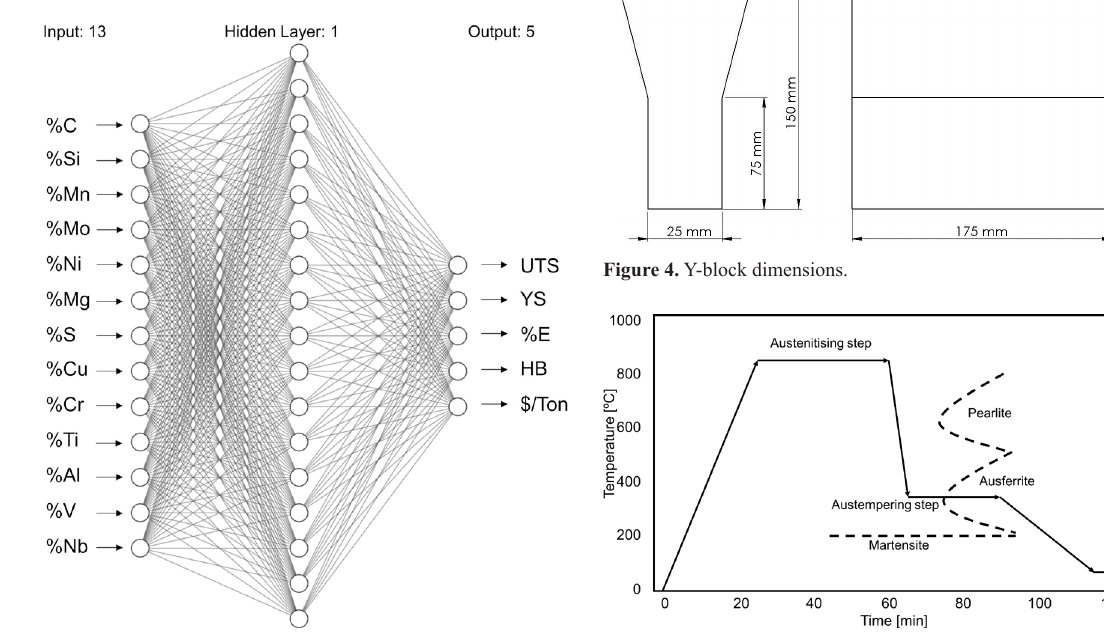
Figure 5. Heat treatment steps for ADI